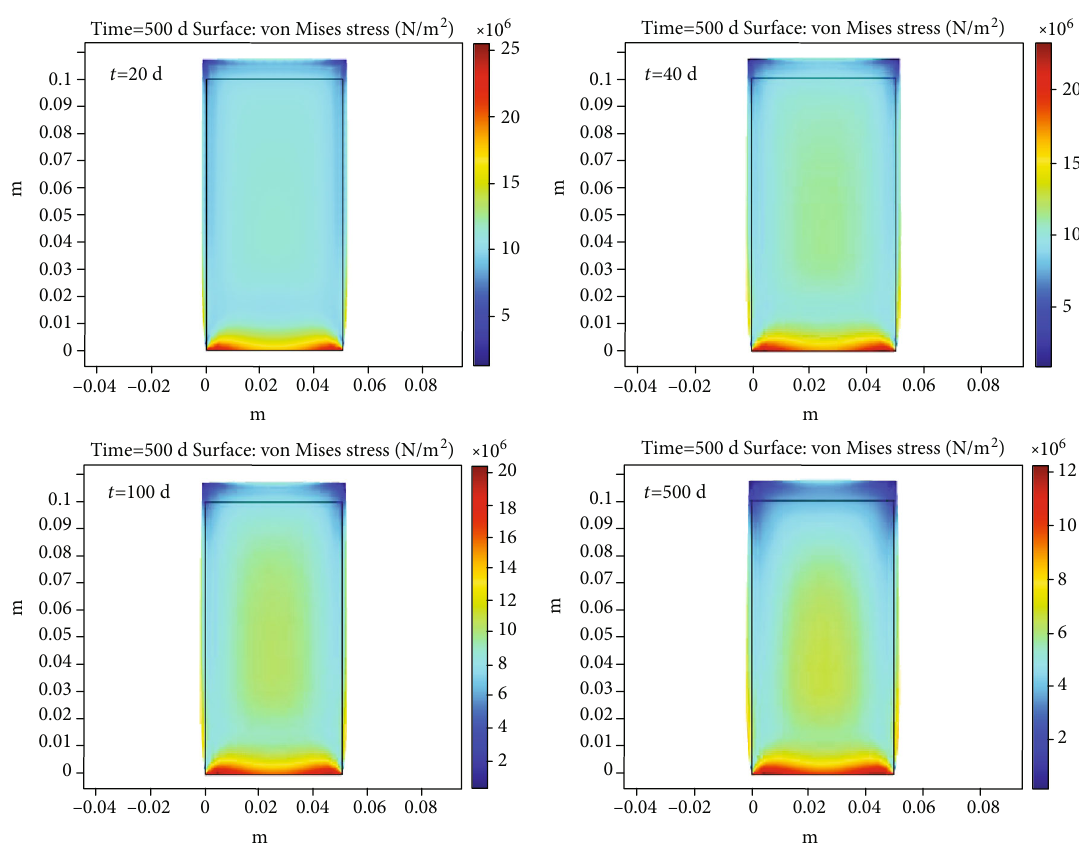
Figure 5: Evolution of stress distribution in